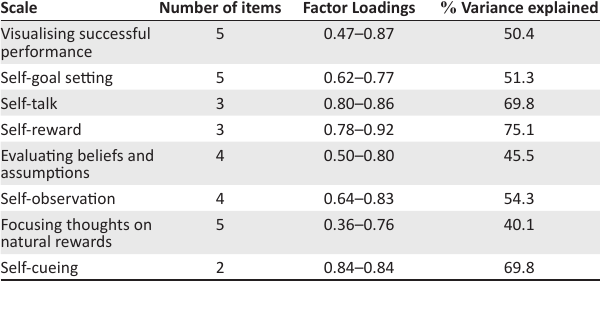
TABLE 3: Exploratory factor analysis output for the RSLQ self-leadership